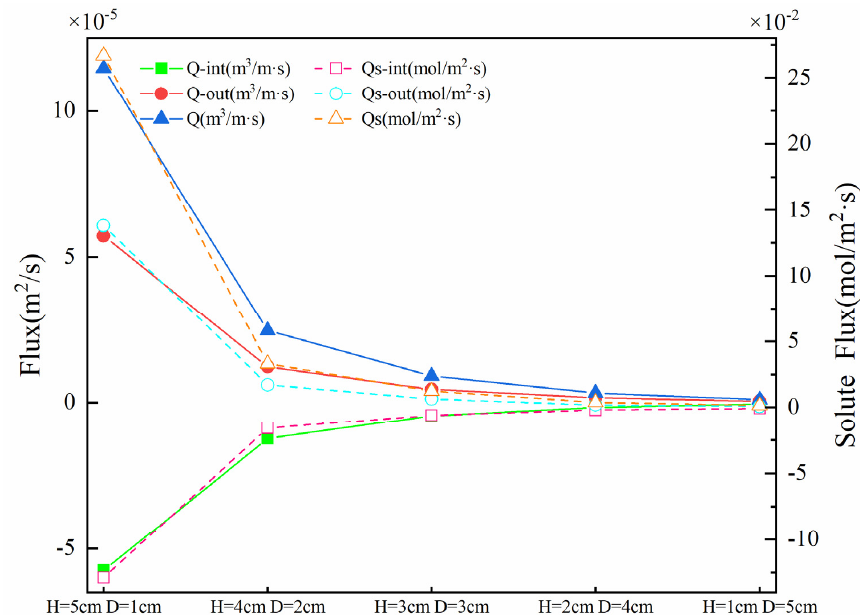
Figure 6. Vertical hyporheic exchange flux (Q), downwelling hyporheic flux (Q int ), upwelling hyporheic flux (Q out ), solute flux (Qs), downwelling solute flux (Q s-int ), and upwelling solute flux (Q s-out ) on the bed surface under different H and D values. The solid lines represent the hyporheic exchange flux; the dashed lines show the solute flux.